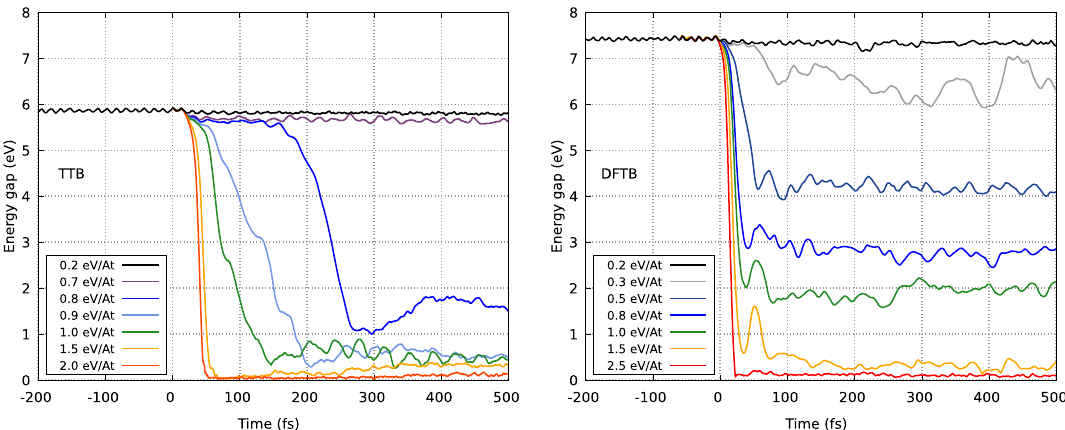
Figure 1. Evolution of band gap in XUV-irradiated diamond predicted with (left) the original XTANT approach, and with (right) XTANT+. The XUV pulse had a duration of 10 fs, the photon energy was 50 eV. The calculations were performed using a 216-atom supercell. The curves represent averages over 7 MD realizations. The figure has been generated using gnuplot 4.6 patchlevel 4 (http:// gnupl ot.